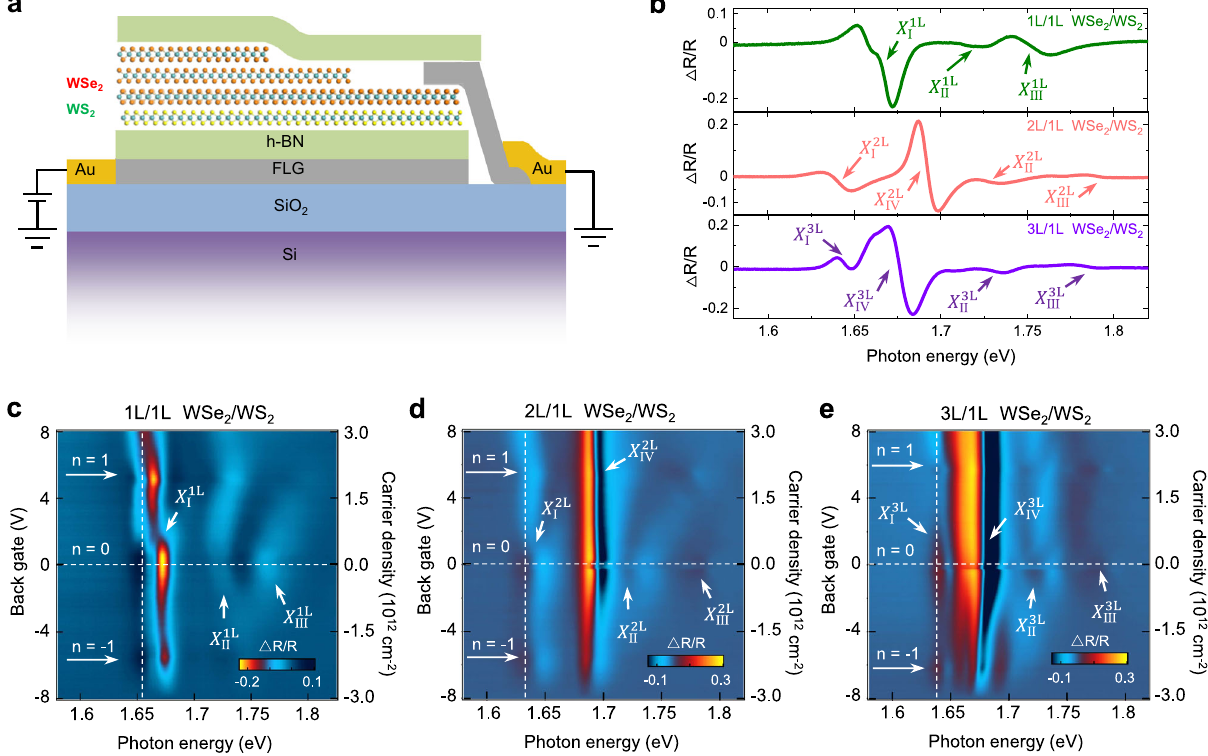
Fig. 1 | Angle-aligned multilayer WSe 2 /monolayer WS 2 moiré superlattice. a Schematic of the multilayer WSe 2 /monolayer WS 2 heterojunction devices, with the heterojunctions encapsulated with fl akes of BN on both sides. The few-layer- graphene (FLG)worksasthebackgateelectrode. b Differentialre fl ectancespectra